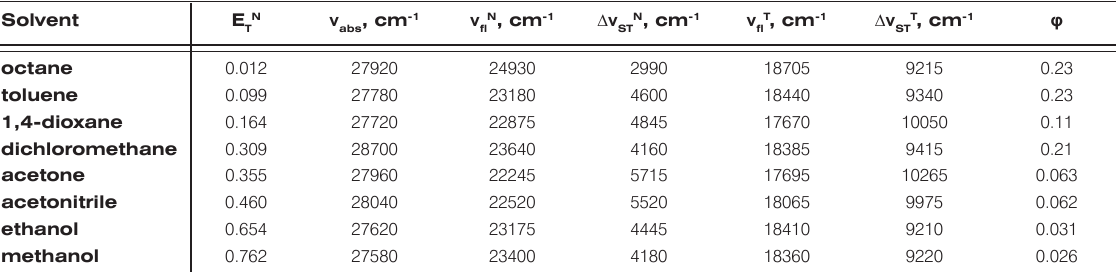
Table 4. Spectral data for bis